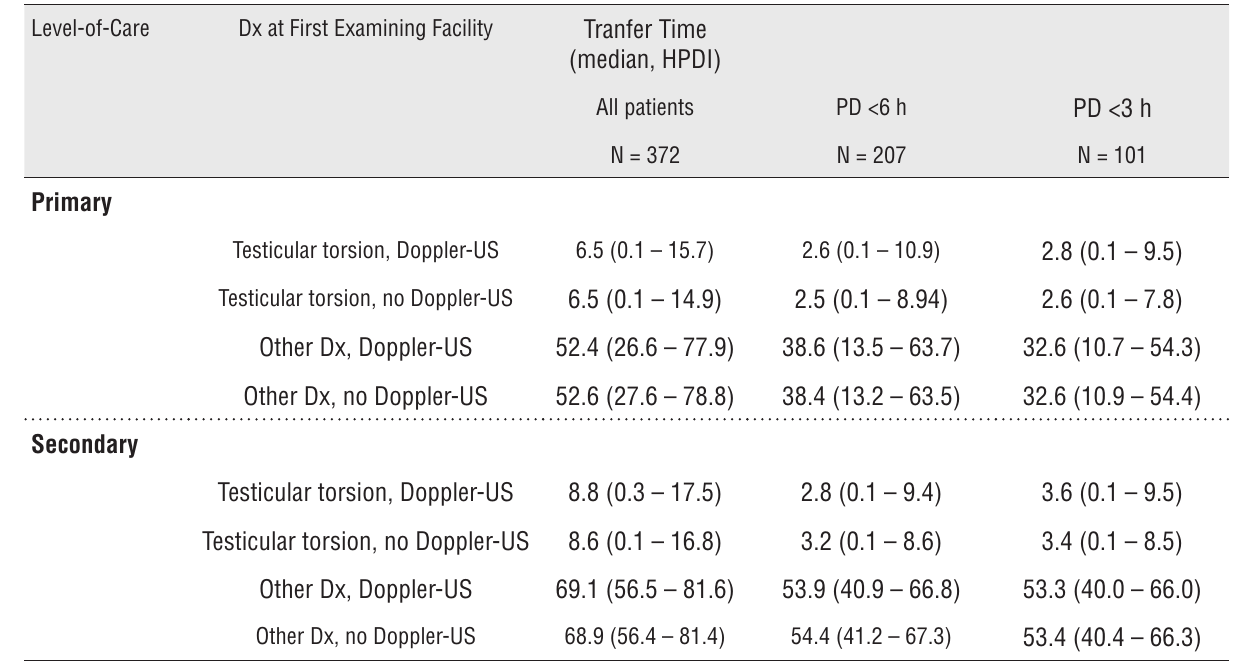
Legend for table 2 - Bayesian linear regression model output. Level-of-care, medical facility’s level of care (primary, secondary); Dx at First Examining Facility, diagnosis at the first examining facility; Transfer Time, time-interval in hours between first examination and examination at the tertiary facility, estimated for all patients as well as for patients with presentation delay (PD) <6 and <3 hours; Doppler-US, request for testicular Doppler-enhanced ultrasonography; HPDI, 0.95 highest posterior density